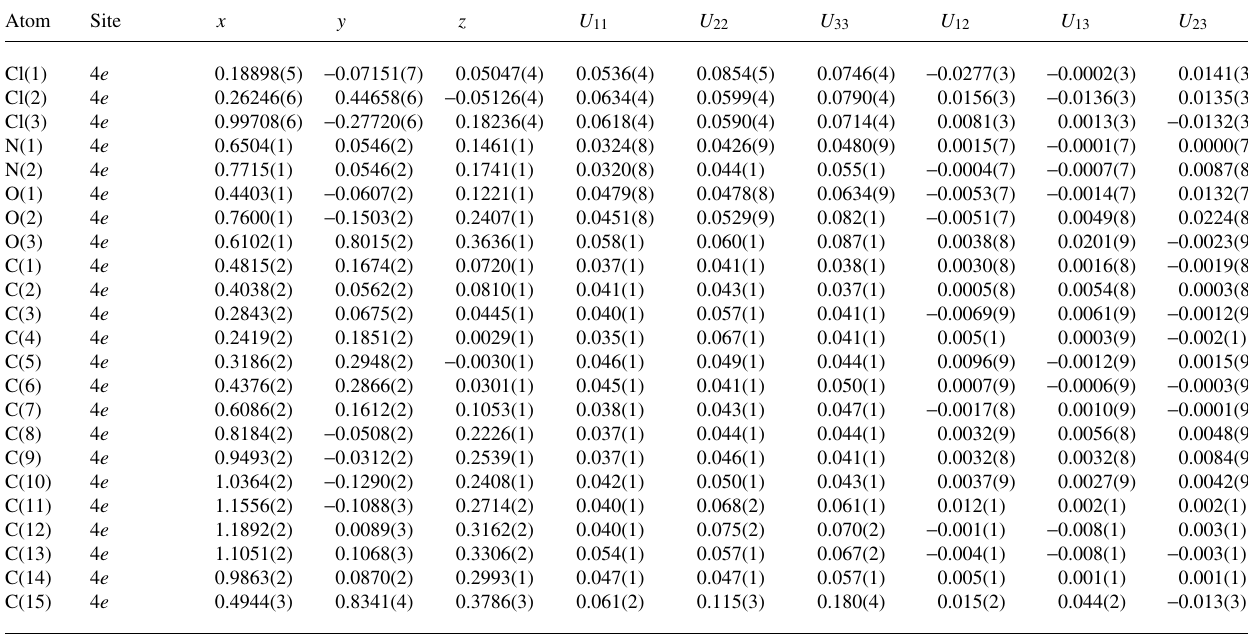
Table 3. Atomic coordinates and displacement parameters (in Å 2 )